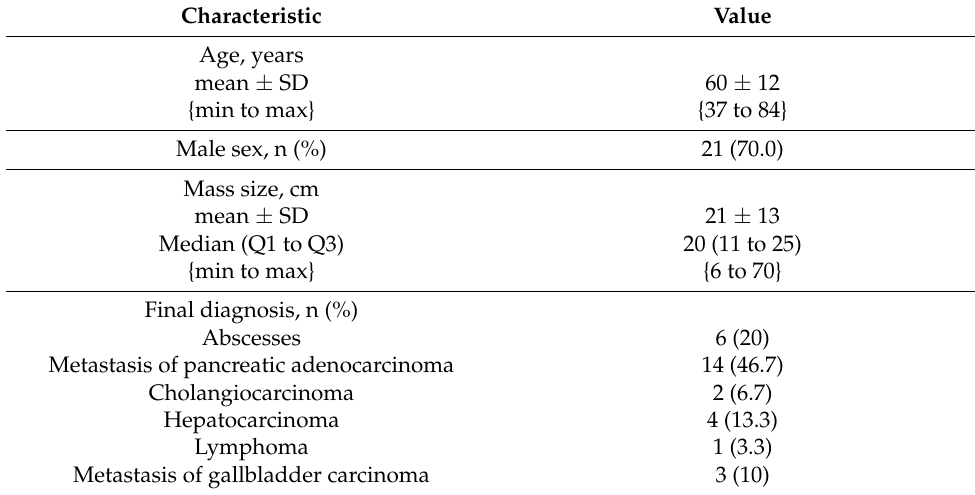
Table 1. Patient characteristics. Table 2. Sample adequacy in the EUS - FNB and EUS - FNA groups and comparisons between FNB and FNA.